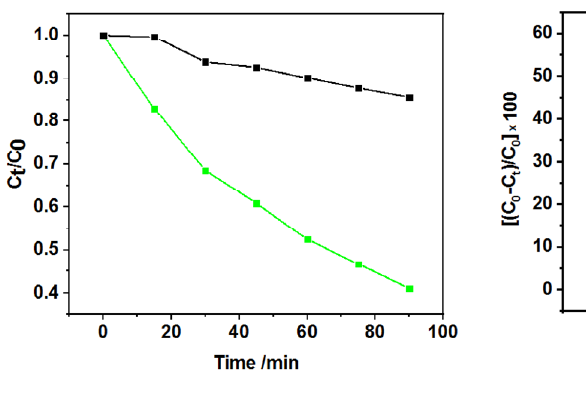
Figure 7. Absorption spectra of methylene blue (MB) ( A ) in the presence and ( B ) in the absence of CdS nanoparticle suspension, both recorded during the irradiation with mercury quartz lamp.